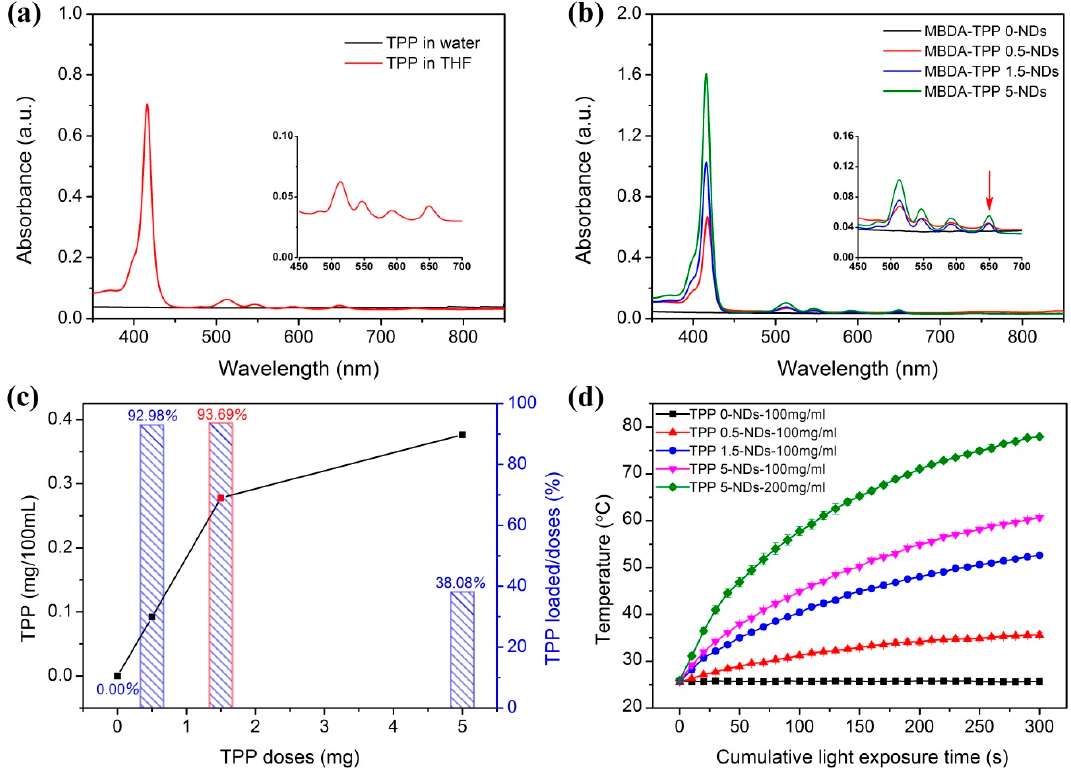
Figure 3. UV–Vis absorption spectrum of different dispersions: ( a ) TPP in aqueous solution and THF; ( b ) micelles without TPP and MBDA–TPP–NPs loaded with different TPP in aqueous solution; ( c ) the TPP concentrations and the corresponding TPP load factor of MBDA–TPP–NPs dissolved in THF at 417 nm; ( d ) Temperature rise of 500 μ L MBDA–TPP–NPs in different concentrations as a function of